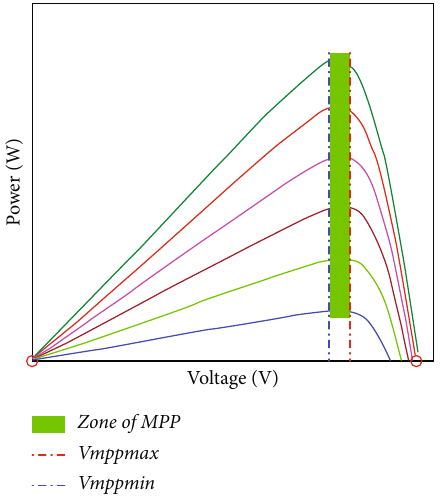
Figure 5: Illustration of the MPP zone in P-V curves under di ff erent insolation levels